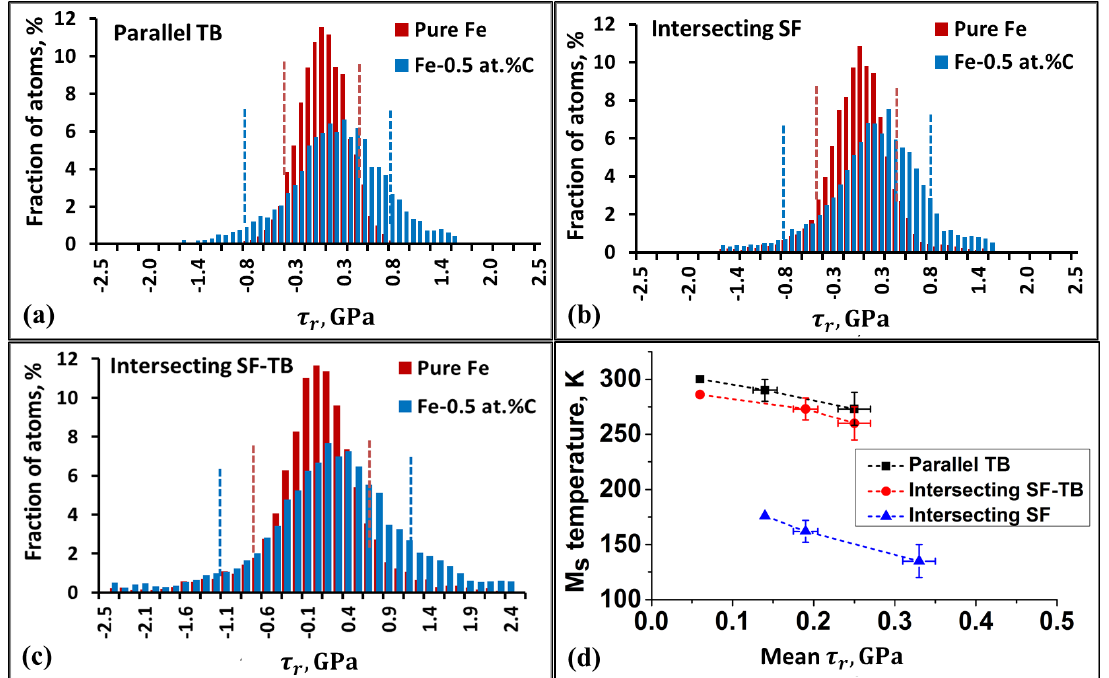
Figure 4. Fraction of atoms vs resolved atomic shear stress ( τ r ) for Pure Fe and Fe-0.5 at. %C. Fcc phase with ( a ) parallel TB, ( b ) Intersecting SF, ( c ) Intersecting SF and TB, ( d ) M s temperature as a function of mean value of τ r for different C concentrations and defect